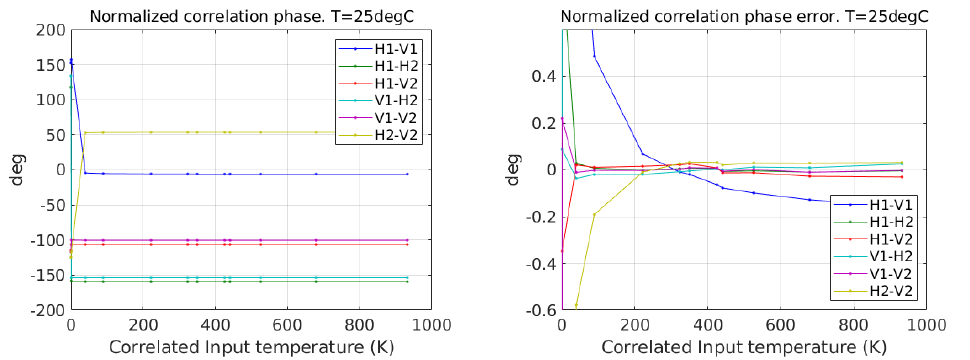
Figure 10. Phase of normalized correlation. The right plot shows the same phase with the average removed to see the